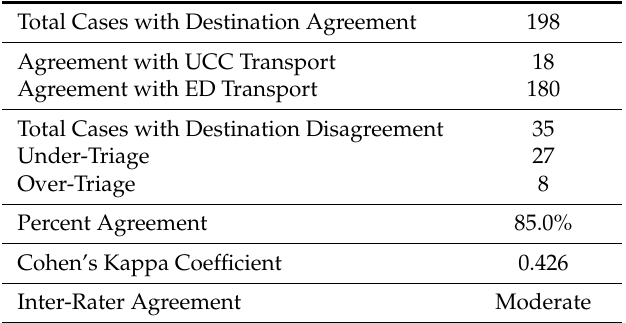
Table 2. Agreement between EMTs and EPs.